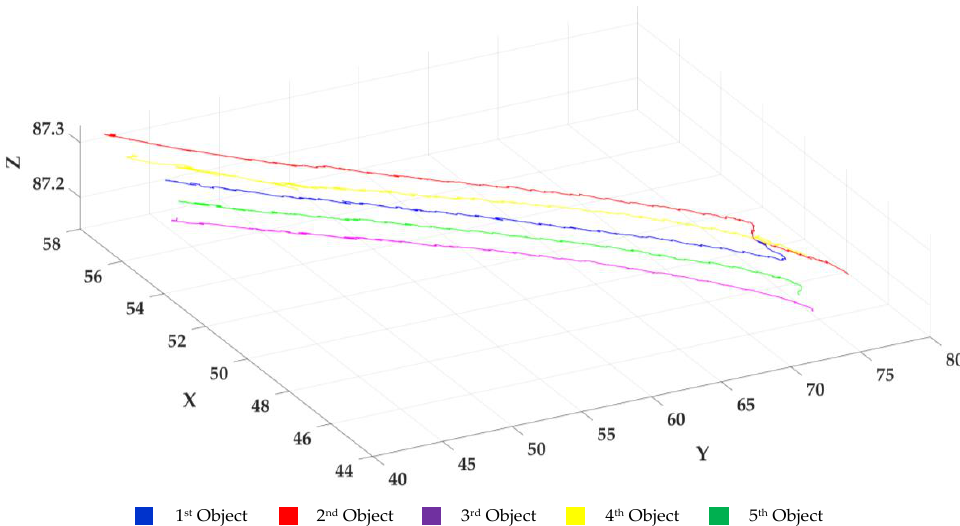
Figure 10. The 3D trajectories of moving objects in the world coordinate system in a graph. The planar positions are the mapping results, and the elevations are the results first filtered by median filtering and then fitted by a cubic polynomial.